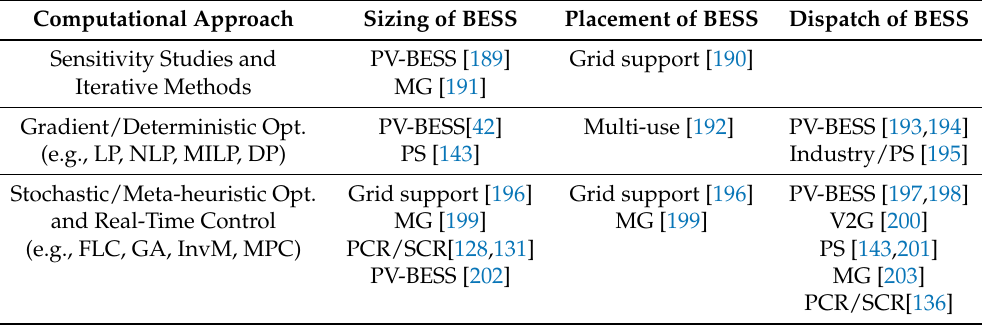
Table 7. Overview to computational approaches for BESS integration to various fields of applications. The table shows a classification of optimization goals versus computational